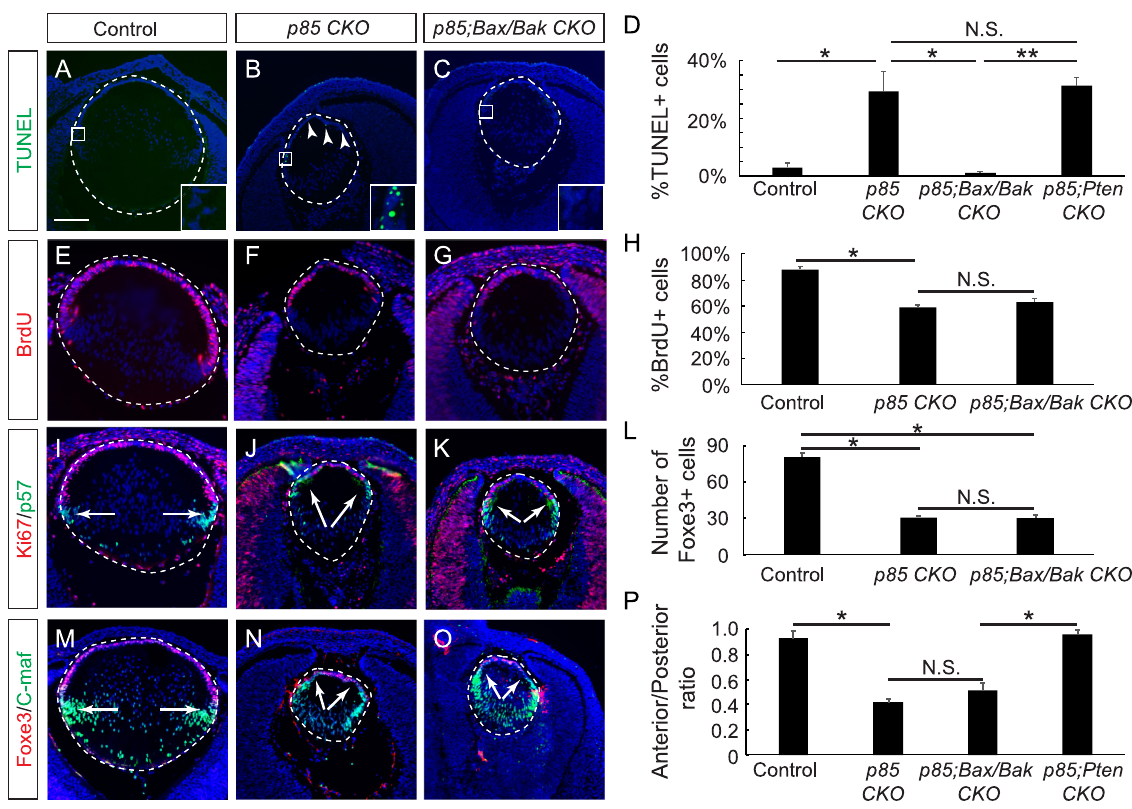
Fig 4. Bax/Bak mutations rescue cell apoptosis but not the loss of lens progenitor cells in p85 CKO . (A–D) Bax/Bak deletion completely blocked the abnormal cell death observed in the p85 CKO lens, as shown by TUNEL staining (one-way ANOVA test, � P < 0.02, �� P < 0.01, n = 4 embryos for p85 CKO , n = 3 embryos for other genotypes). (E–H) The cell proliferation as indicated by the incorporation of BrdU was significantly reduced in both p85 CKO and p85;Bax/Bak CKO (one-way ANOVA test, � P < 0.0001, n = 3 embryos for each genotype). (I–O) Ki67, p57, Foxe3, and C-maf immunostaining showed that the deletion of Bax and Bak did not revert the anterior shift of the transitional zone (one-way ANOVA test, � P < 0.0001, n = 3 embryos for each genotype). (O) The length of the anterior epithelium was quantified against the perimeter of the posterior lens-fiber–cell compartment. One-way ANOVA test, � P < 0.0001, n = 9 embryos for the control, n = 7 for p85 CKO , n = 10 for p85;Bax/Bak CKO , n = 5 embryos for p85;Pten CKO . Scale bar: 100 μ m. The numerical data used in panels D, H, L, and P are included in S1 Data. Bak, BCL2 Antagonist/Killer; Bax, BCL2-Associated X; BCL2, B-cell lymphoma 2; BrdU, Bromodeoxyuridine; C-maf, MAF BZIP Transcription Factor; Foxe3, Forkhead Box E3; KO, knockout; N.S., not significant; Pten, phosphatase and tensin homolog; p85; Bax/Bak CKO , Le-Cre;p85 α f/f ;p85 β KO/KO Bax flox/flox ;Bak KO/KO ; p85 CKO , Le-Cre;p85 α f/f ;p85 β KO/KO ; p85;Pten , Le-Cre;p85 α f/f ;p85 β KO/KO ;Pten f/f